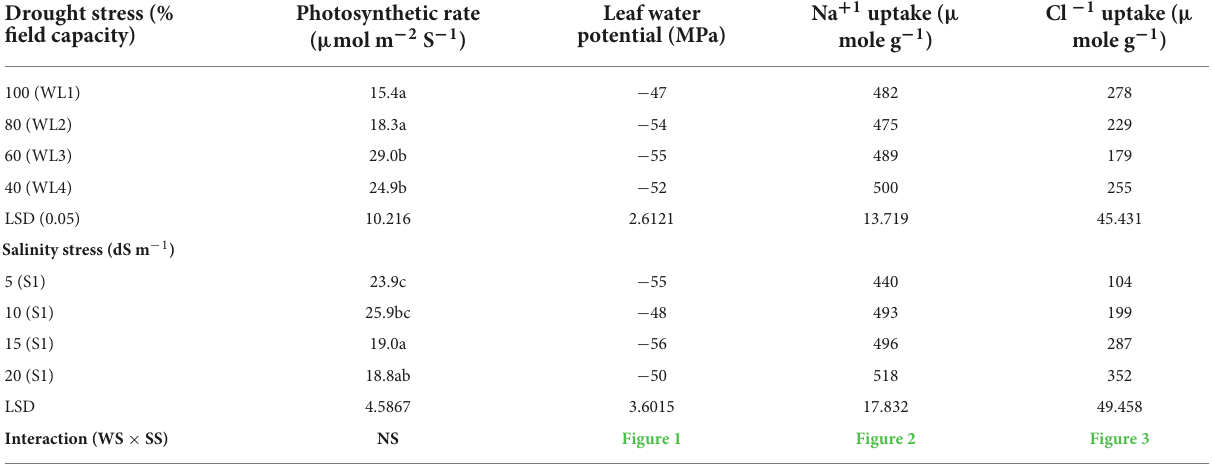
TABLE 3 Physiological response of Atriplex leucoclada to varying drought and salinity stresses. Drought stress (% field